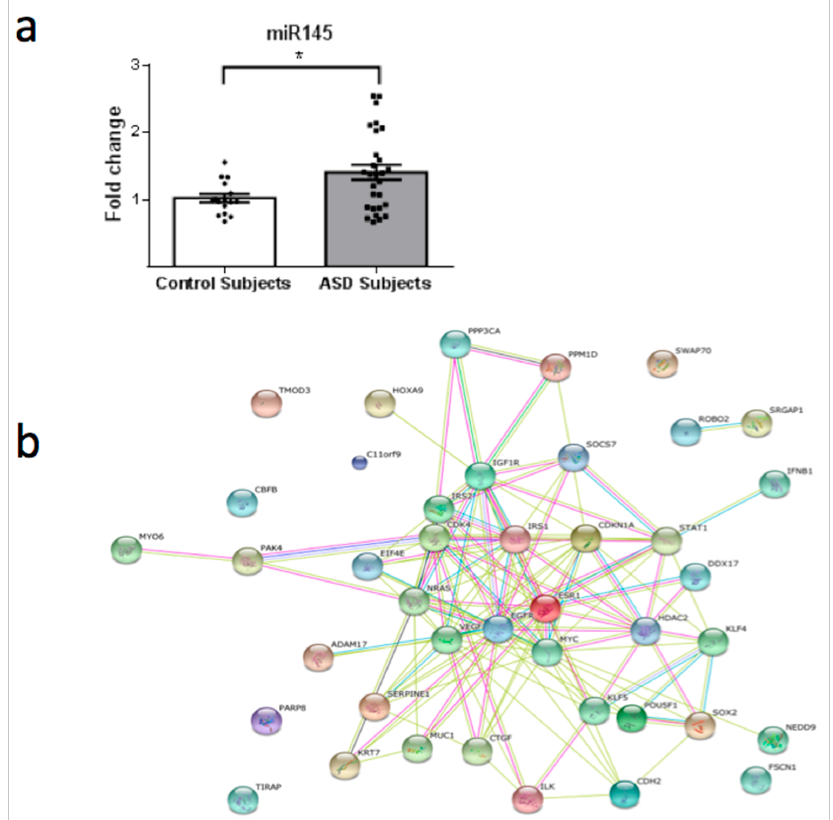
Figure 2. ( a ) Scatter plot of differential relative expression of miR145 in peripheral blood of